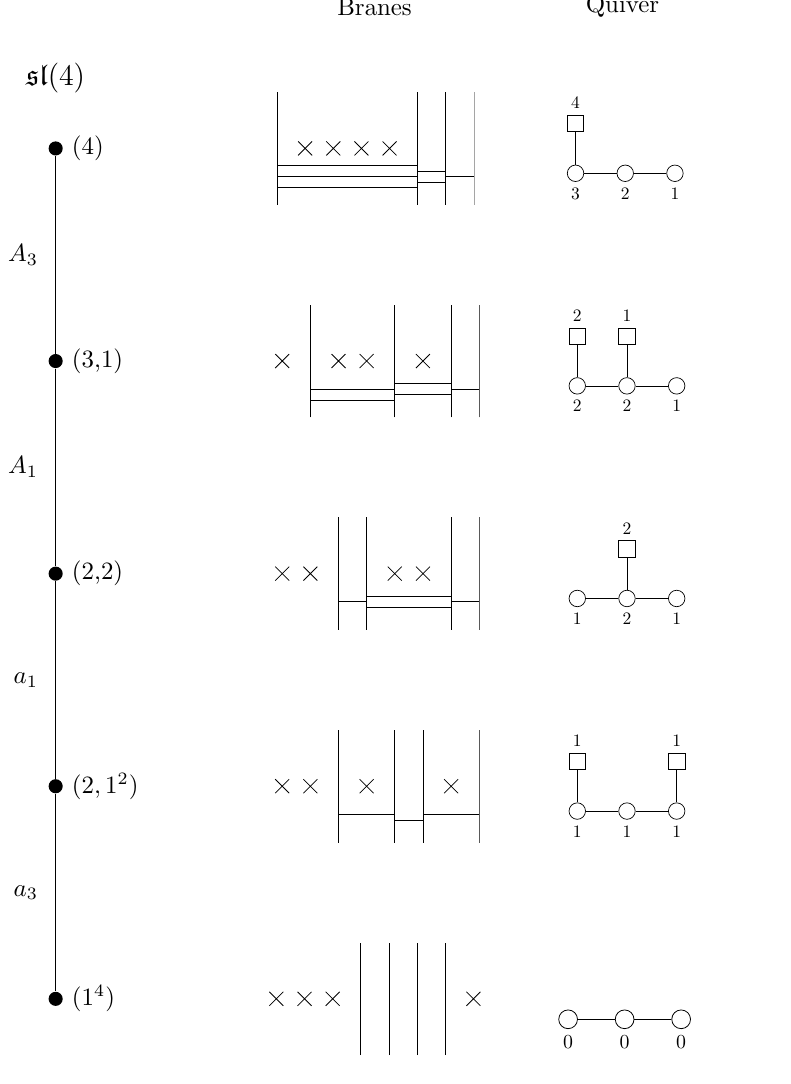
Figure 10. Hasse diagram for sl (4). Note that a